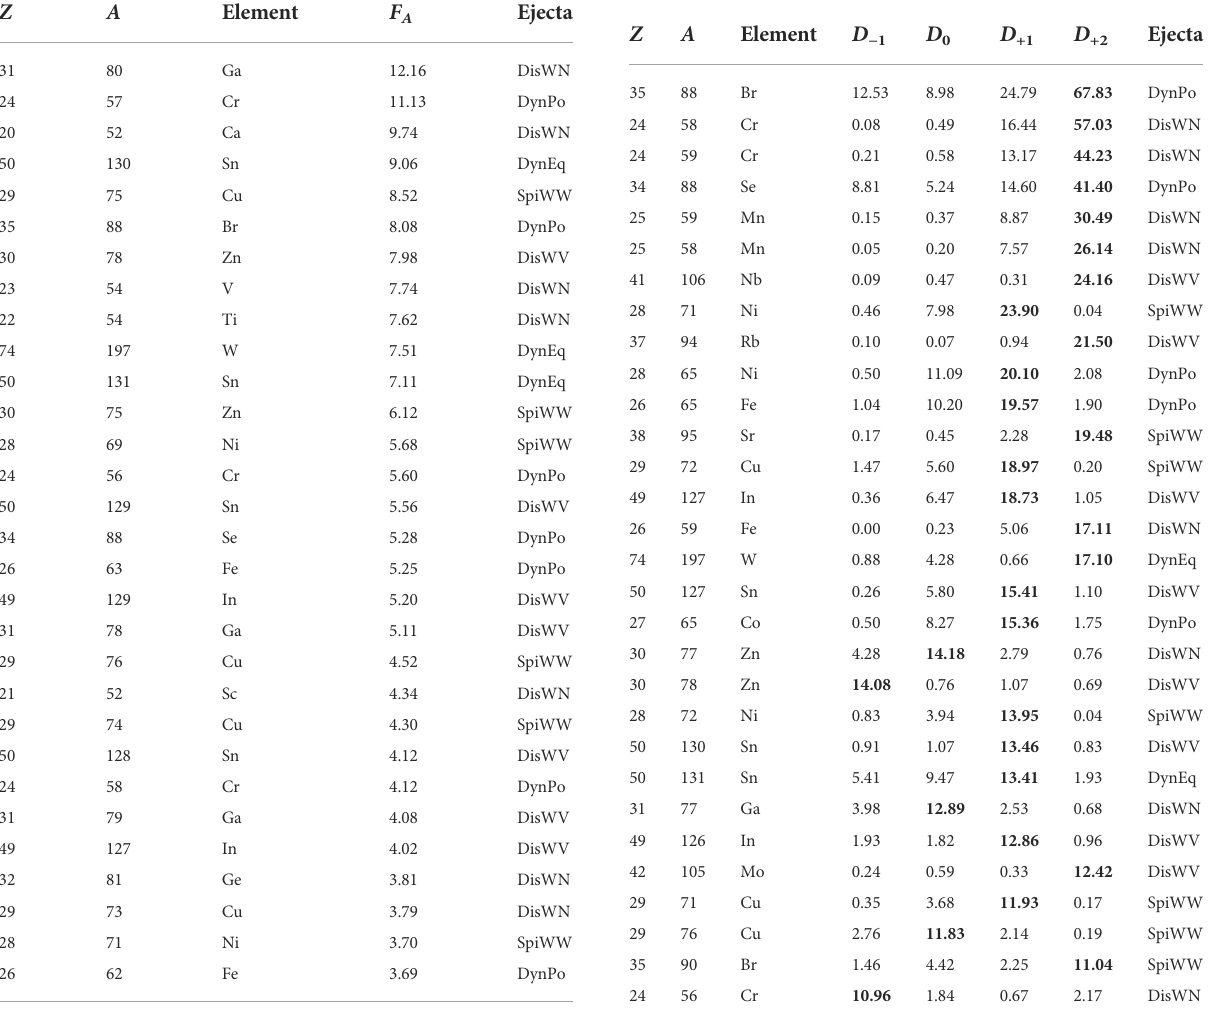
TABLE1Top30nucleiwithmaximumneutron-captureratesensitivity measure F A for the fi ve NSM ejecta trajectories considered in this study.Foreachspeci fi cnucleus,therelative F A valueisthelargestone obtainedinthefullsetofsensitivitystudiesandreferstotheparticular type of ejecta listed.